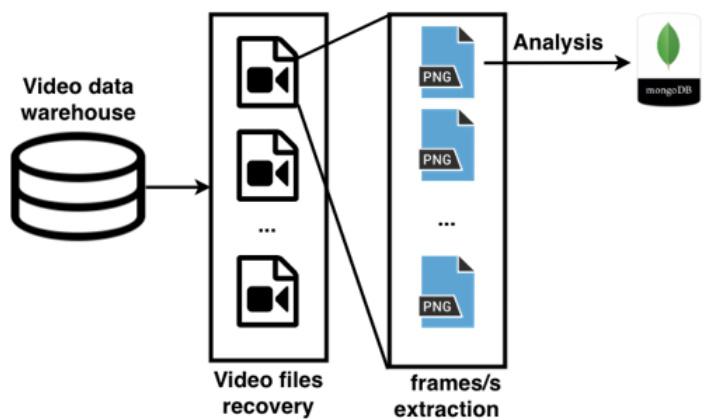
Figure 6. Schema of the process used to convert videos into